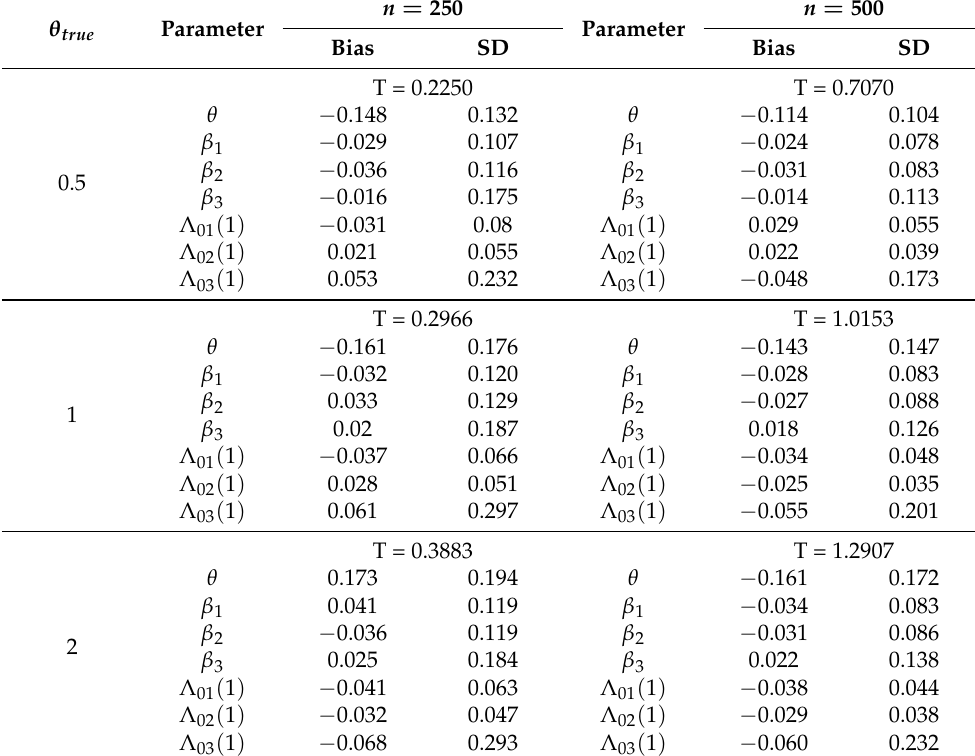
Table 2. The simulation results of the illness–death model with gamma frailty at 50% censoring